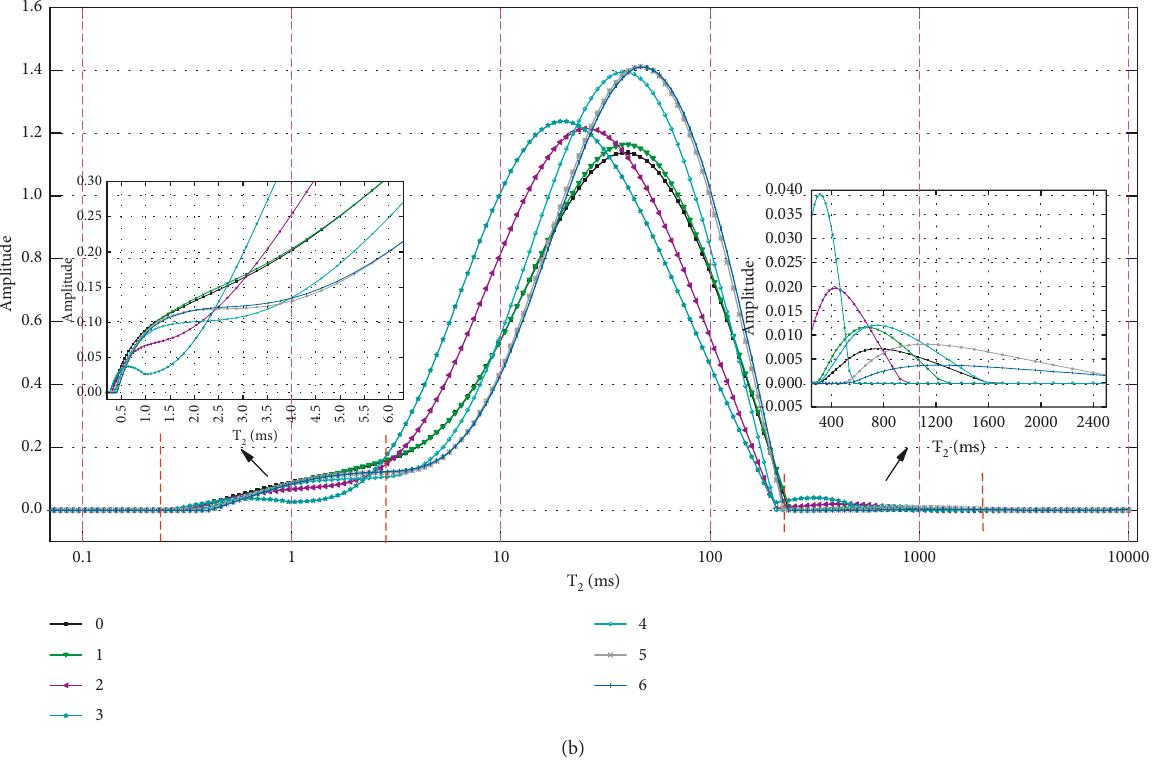
Figure 8: Sample leaching T 2 spectrum distributions. (a) Pure water leaching T 2 spectrum distribution. (b) Ammonium chloride leaching T 2 spectrum distribution.